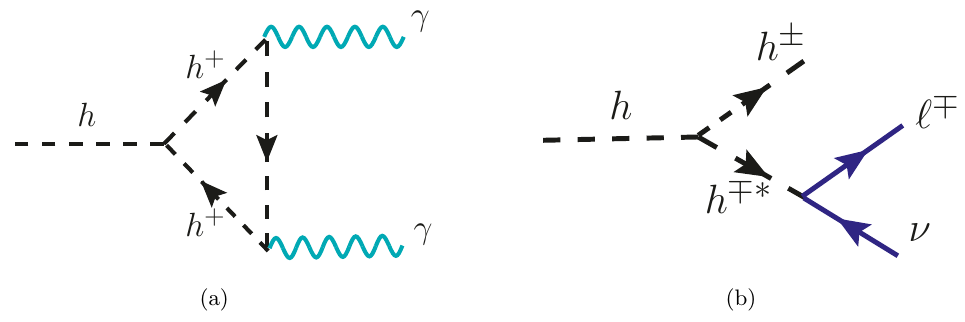
Figure 14 . (a) New contribution to h contribution to h 2 ‘ 2 (cid:23) via the exotic decay mode h !